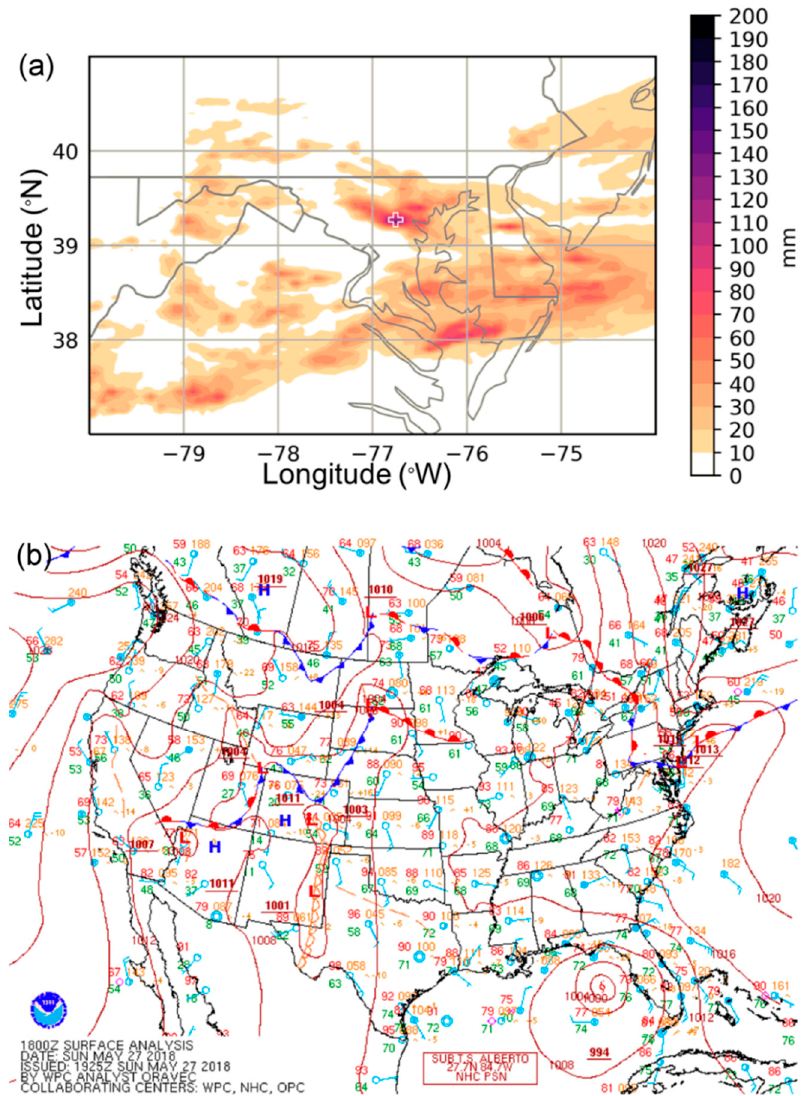
Figure 2. Meteorological overview of the May 2018 flood. (a) Stage IV estimated rainfall totals for the 24 h period ending 12 UTC 28 May 2018 and (b) NWS Weather Prediction Center surface maps for the continental United States valid at 18 UTC 27 May 2018. In the top panel, the location of Ellicott City is indicated by a plus sign near the center of the domain at 39.27°N, 76.80°W.